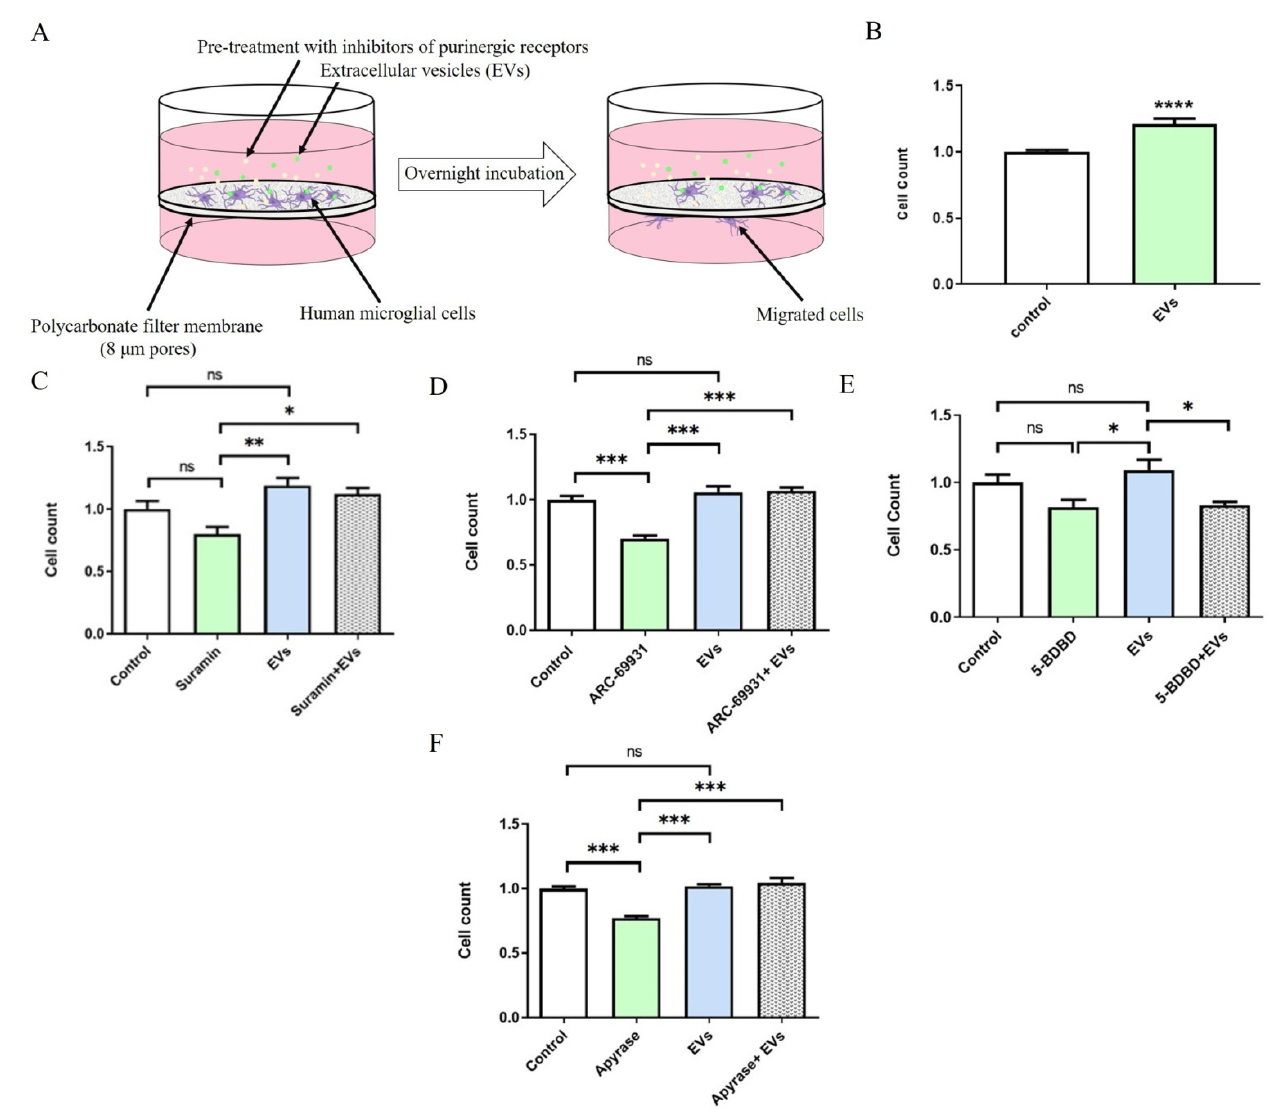
Figure 4. EVs promote migration of microglia through P2X4R-dependent mechanisms. ( A ) Migration assays were performed in a Boyden 10 well chemotaxis chamber (Neuro Probe) using 8 μ m pore polycarbonate membranes. Microglial cells were plated into the upper wells, pre-treated for 30 min with inhibitors of different subtypes of purinergic receptors, treated with 1 AU of EVs, and then left overnight. The number of cells that transmigrated to the opposite side of the membrane was determined using optical microscope in three randomly chosen fields from at least three wells for each experimental group. ( B ) EVs promote migration of human microglial cells. Data represent mean ± SEM values, Welch’s test, **** p < 0.0001; n = 22. ( C ) The effects of nonselective antagonist of ATP-gated P2 receptors suramin (200 μ M); ( D ) inhibitor of P2Y12 AR-C69931 (1 μ M); ( E ) selective inhibitor of P2X4R 5-BDBD (10 μ M); ( F ) ATP degrading enzyme apyrase (20 U/mL). For these experiments, apyrase and 1 AU of EVs were added simultaneously to the upper wells and cells were incubated overnight. Data represent measurements from three independent experiments (only treatment with 5-BDBD from five). The graph represent mean ± SD values, groups were compared with one-way ANOVA, Tukey’s multiple comparisons test, * p < 0.05, ** p < 0.01, *** p < 0.001, ns: not significant.